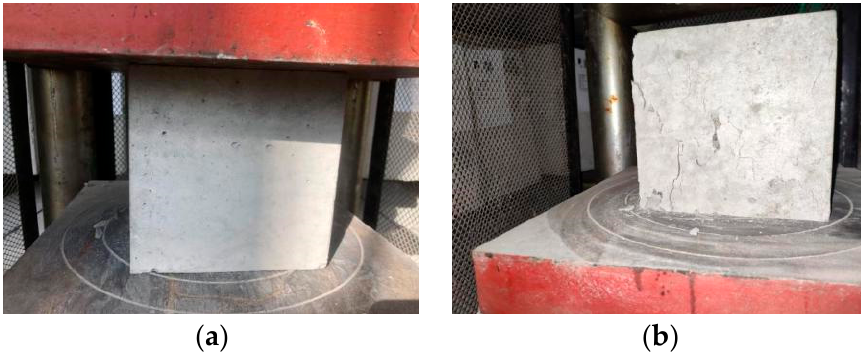
Table 1. Compressive strength of C35 concrete at different ages.